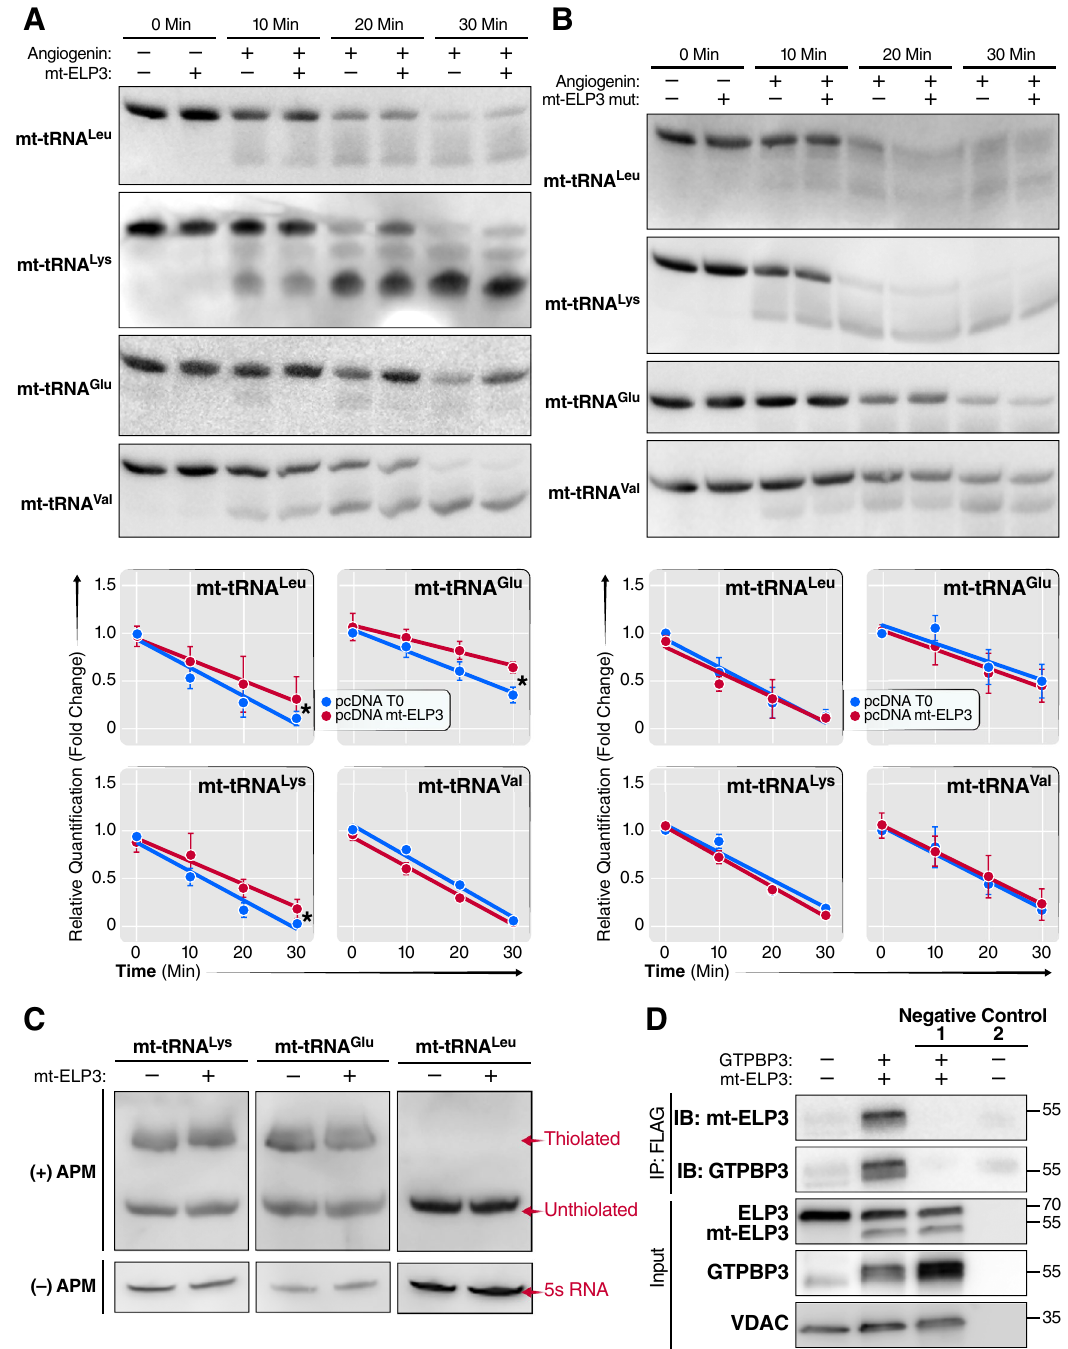
Figure 3. Overexpression of mt-ELP3 protects mt-tRNAs substrate from angiogenin-mediated cleavage without altering 2-thiolation levels. ( A ) and ( B ) Northern analysis of mt-tRNA Lys , mt-tRNA Leu , mt-tRNA Glu and mt-tRNA Val after in vitro angiogenin digestion of small RNAs purified from control cells and cells overexpressing mt-ELP3 ( A ), and from control cells and cells overexpressing mt-ELP3 mut ( B ) for the indicated times. The accompanying histogram shows the kinetic analysis of angiogenin digestions. The amounts of intact mt-tRNA after 0, 10, 20 and 30 min of incubation with angiogenin are represented as fold-changes relative to the undigested control (0 min). All data are mean ± SD of at least three experiments. * p < 0.05. ( C ) APM-northern analysis of 2-thiolation of mt-tRNA Lys , mt-tRNA Leu and mt-tRNA Glu from control cells and cells overexpressing mt-ELP3. The same amounts of total RNA (5 µg) were run in a denaturing polyacrylamide-urea gel in the presence (+) or absence (−) of APM. The thiolated tRNAs were detected as retarded bands in the presence of APM. The APM (−) membrane was probed with 5S rRNA as a loading control. ( D ) mt-ELP3 interacts with GTPBP3 . HEK 293T cells were co-transfected with pcDNA mt-ELP3-Flag and pCMV6 GTPBP3 plasmids as indicated, and the lysates were immunoprecipitated with anti-Flag antibody. Precipitated proteins were immunoblotted with anti-ELP3, GTPBP3 and VDAC antibodies. Beads mixed with lysate without anti-Flag antibody and beads mixed with anti-Flag antibody without lysate were used as a negative control 1 and 2,